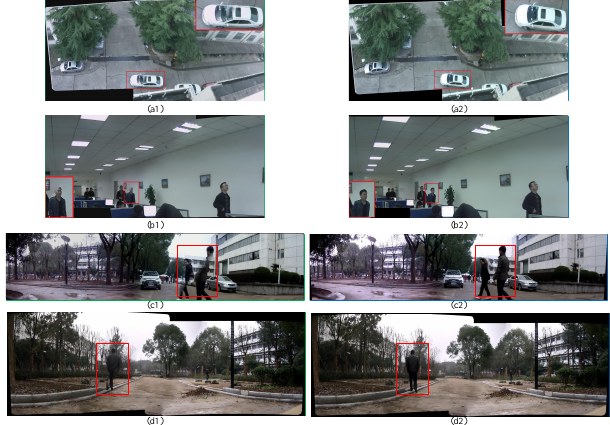
Figure 8. Frames taken from the output Field-of-View (FOV) videos: ( a1 – d1 ) are taken from the output videos using initialized seam without updating. ( a2 – d2 ) are taken from the output video using change-detection based seam updating approach. ( a1 ), ( a2 ), ( b1 ) and ( b2 ) are the stitching results of two channels of 720P videos. ( c1 ) and ( c2 ) are the stitching results of three channels of 720P videos. While for ( d1 ) and ( d2 ), they are the stitching results of four 720P